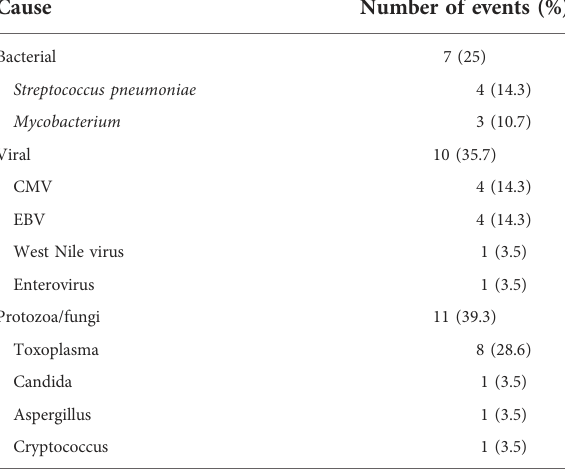
TABLE 3 Causes of infectious neurological complications ( n =28). TABLE 4 Multivariate analysis of signi fi cant variables associated with neurological